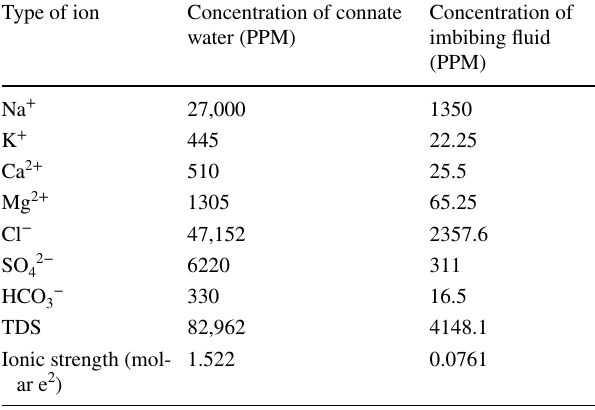
Fig. 1 Schematic of core-flooding apparatus (McGuire et al.